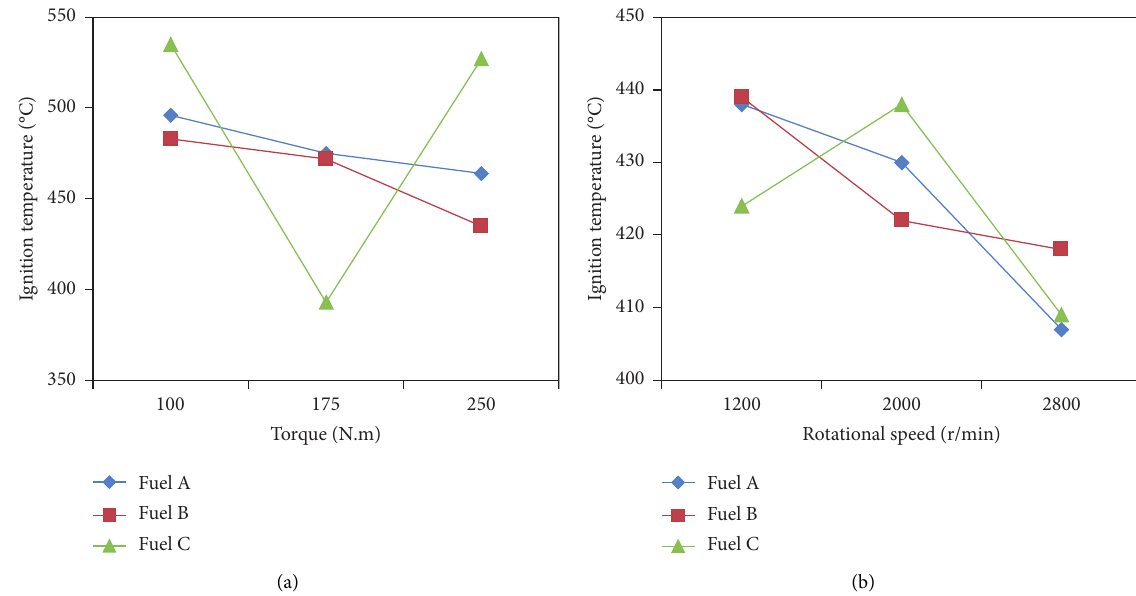
Figure 4: The ignition temperature of PM under various operating conditions. (a) Different torque. (b) Different rotational